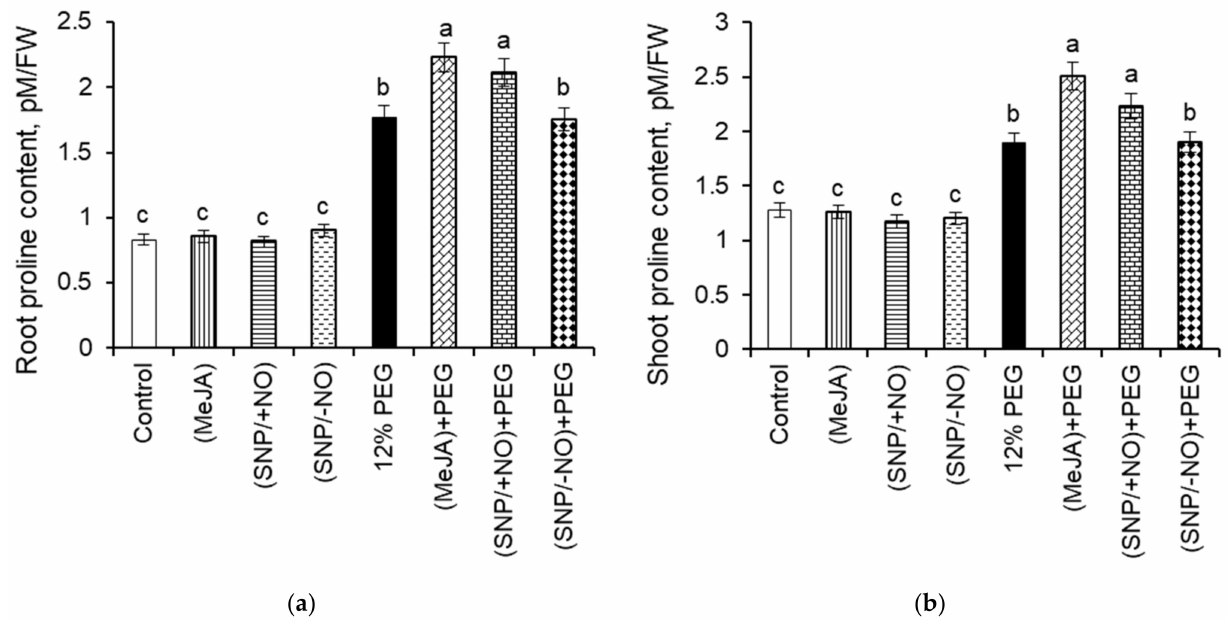
Figure 6. Proline content of roots ( a ) and shoots ( b ) of wheat plants pretreated by 10 − 7 M MeJA or 2 × 10 − 4 M SNP under 12% PEG application during 24 h. Data are the mean of three replicates; different letters show significant difference at p ≤ 0.05 and bars indicate ± SE (n = 15).